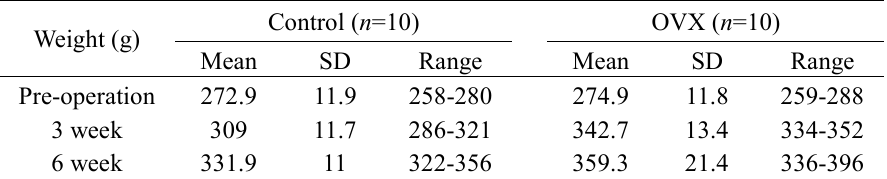
Table 1. Weight of control and OVX rats at pre-operation, 3 and 6 weeks .